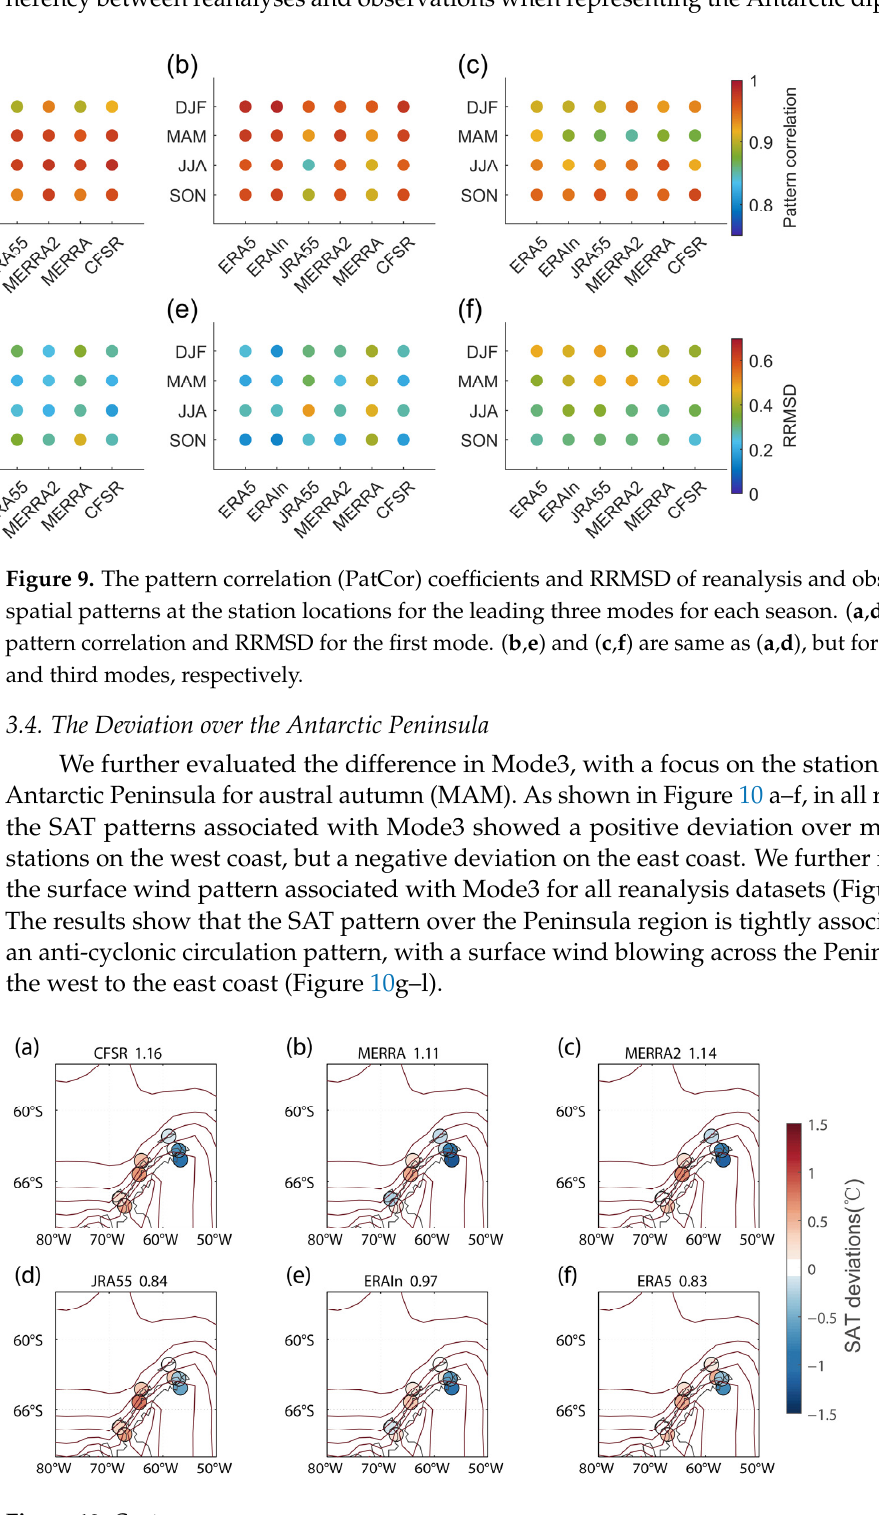
Figure 10. The combined maximum covariance analysis (CMCA) for Mode3 in the Antarctic Penin- sula during austral autumn (MAM): ( a – f ) same as Figure 6, but for the Antarctic Peninsula region. The contour intervals are 0.25. The number at the top of each panel represents the temperature bias between the east and west Antarctic Peninsula; ( g – l ), the regression map of 500hPa geopotential height (GPH500, color shading) and u, v component of 10m wind (arrows). Previous studies indicated that the regional temperature variability around the Ant- arctic Peninsula is highly influenced by the Foehn wind [9,45–47]. The Foehn wind is in- duced by the adiabatic heating at the lee slope of the Trans-Antarctic Mountains, which contributes to the steep topography over the Antarctic Peninsula [45,47]. However, as they are limited by the spatial resolution, most reanalysis datasets cannot resolve this steep topography over the Antarctic Peninsula, and thus may underestimate the effect of the adiabatic wind, leading to an opposite sign for the deviation between the east and west coast (Figure 10a–f). We further evaluated this opposite sign of SAT deviation between the east and west coast of the Peninsula for other seasons (Figure 11). This deviation is relatively stronger for austral spring (Figure 11d) and autumn (Figure 11b), largely due to the stronger wind anomaly across the Peninsula (Figure 11h,f) for these two seasons.